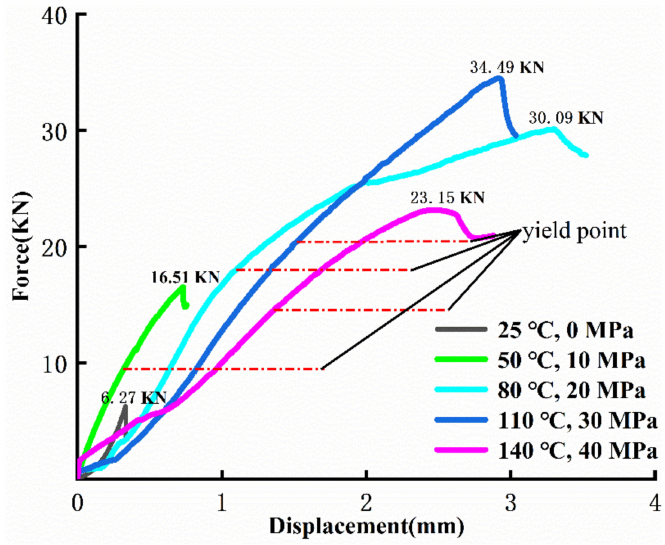
Figure 6. Load-displacement curves under different temperatures and